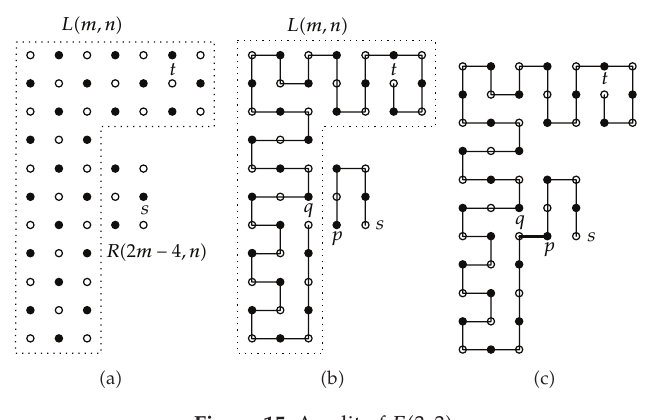
Figure 15: A split of F (cid:6) 3 , 3 (cid:7) .